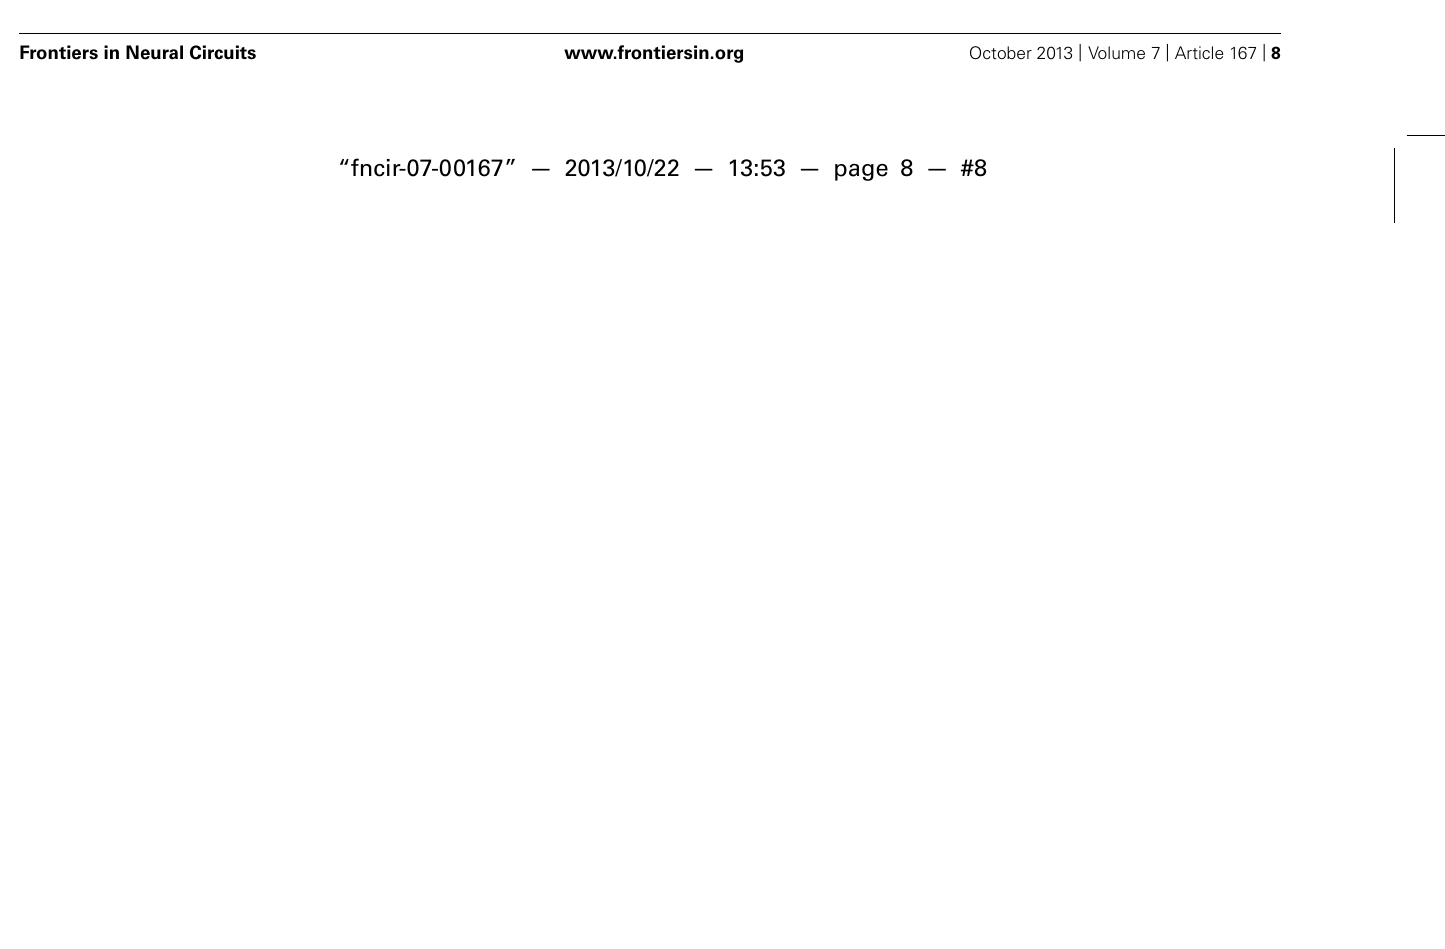
blue lines mark the 95% bootstrap confidence interval.The light blue column in panels ( B,D,F ; 120 and 200 s) marks the light stimulation period with pulsed stimulation protocol. P values on each plot give the significance level for the increase of FR, burst occurrence rate, or IBFR during the last 2 min of recording, respectively. Results for the control experiments of transduced cultures without light stimulation are averages over seven experiments in seven cultures. Results with stimulated non-transduced cultures are averages over five experiments in five